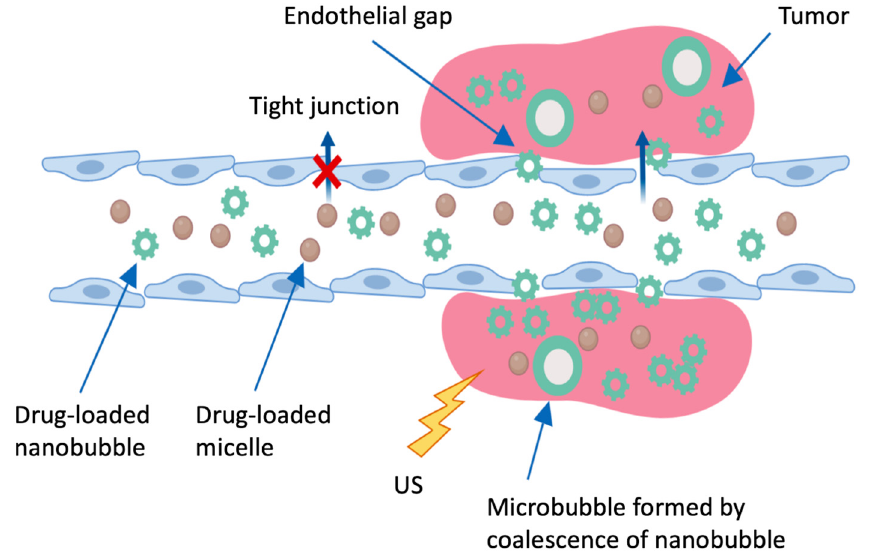
Figure 6. Schematic representation of the targeting of anti-cancer agents through defective tumor microvasculature using the system of delivery of echogenic particles. The microbubbles formed by the fusion nanobubbles become echogenic once inside the tumor. Created with Biorender; Adapted from [138], MDPI, 2020.